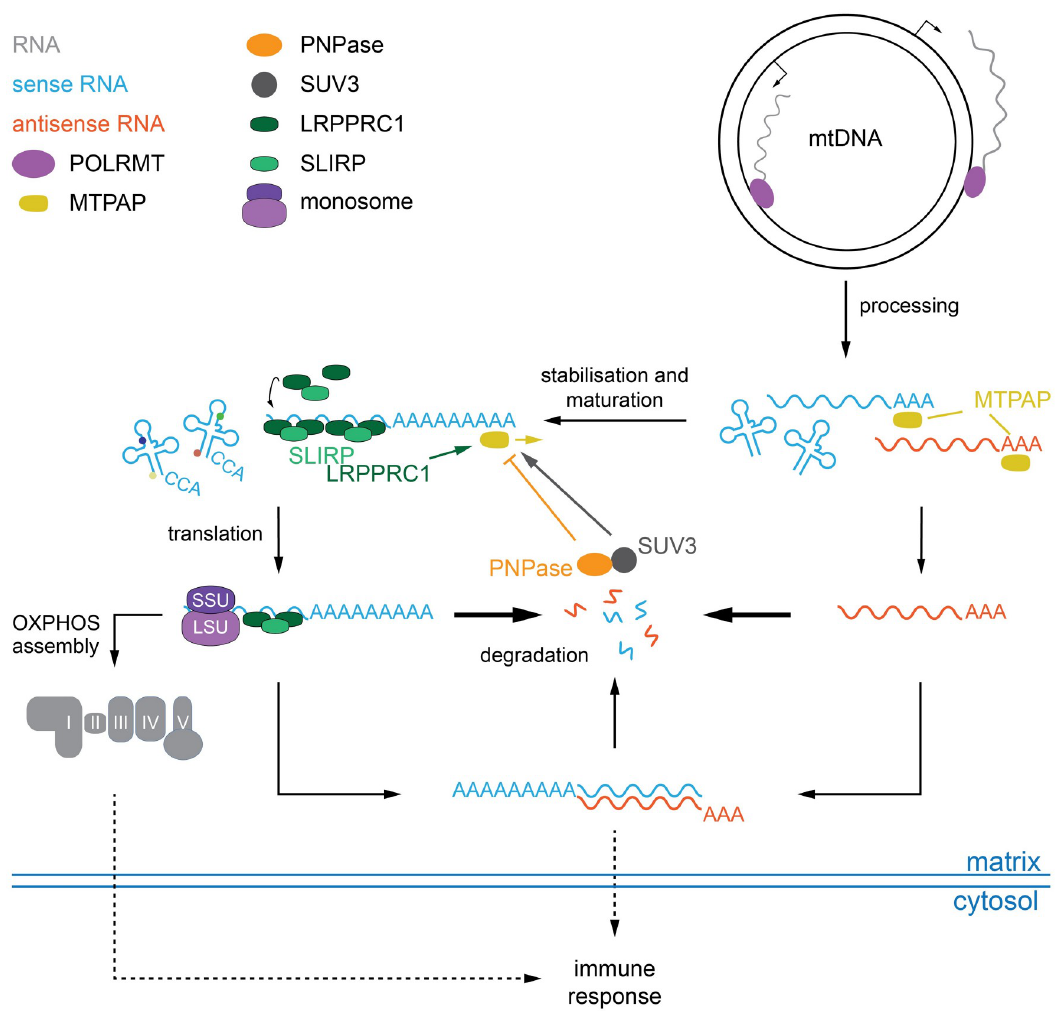
Fig 6. Schematic diagram of the proposed degradation pathway of mitochondrial transcripts. Transcription by POLRMT of polycistronic transcripts is initiated from two promoters on either strand of the mitochondrial genome (mtDNA). Processing into individual, immature transcripts is performed by the RNase P and RNase Z complexes (not indicated), before MTPAP adds short poly(A) extensions to the 3 0 ends of both sense and antisense RNAs and potentially also to selected tRNAs. Coding RNAs are stabilised by the LRPPRC/SLIRP complex, matured and fully polyadenylated in an MTPAP/LRPPRC/SUV3-dependent manner. An unknown mechanism targets antisense RNAs directly for degradation by the PNPase/SUV3 complex. In the absence of degradation, or polyadenylation, antisense RNAs are stabilised allowing for the formation of dsRNAs, which are expelled from the mitochondrial matrix by an unknown mechanism. The accumulation of mitochondrial-derived nucleic acids and/or an OXPHOS dysfunction triggers an antiviral immune